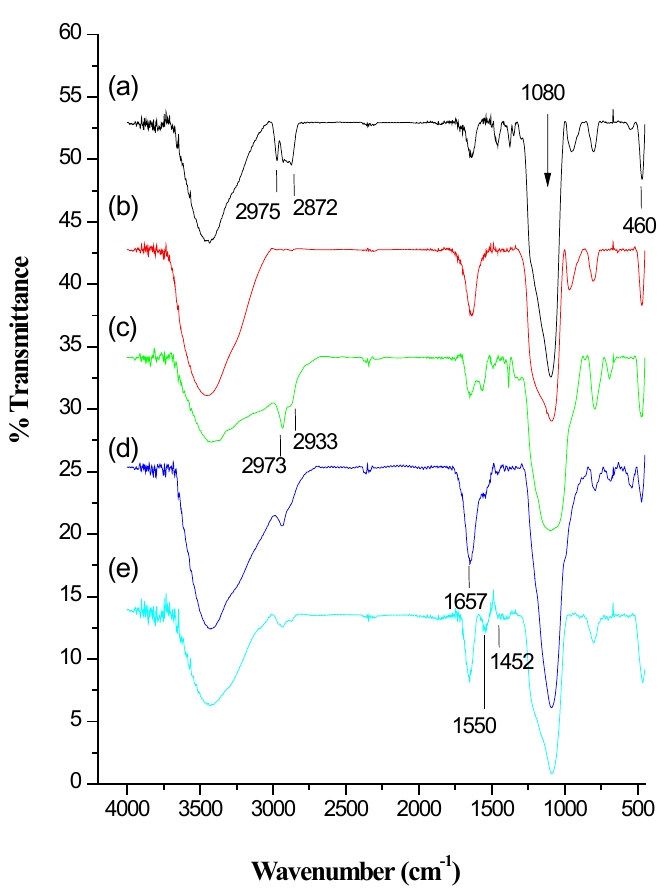
Figure 4. Fourier transform infrared spectroscopy (FT-IR) spectra of the ( a ) as-synthesized IBN-4 nanoparticles, ( b ) IBN-4 nanoparticles after surfactant removal (IBN-4-extracted), ( c ) IBN-4 nanoparticles modified with APTS groups (IBN-4-NH 2 ), ( d ) IBN-4-NH 2 nanoparticles modified with glutaraldehyde groups (IBN-4-NH-GA) and ( e ) IBN-4-NH- GA nanoparticles immobilized with HRP